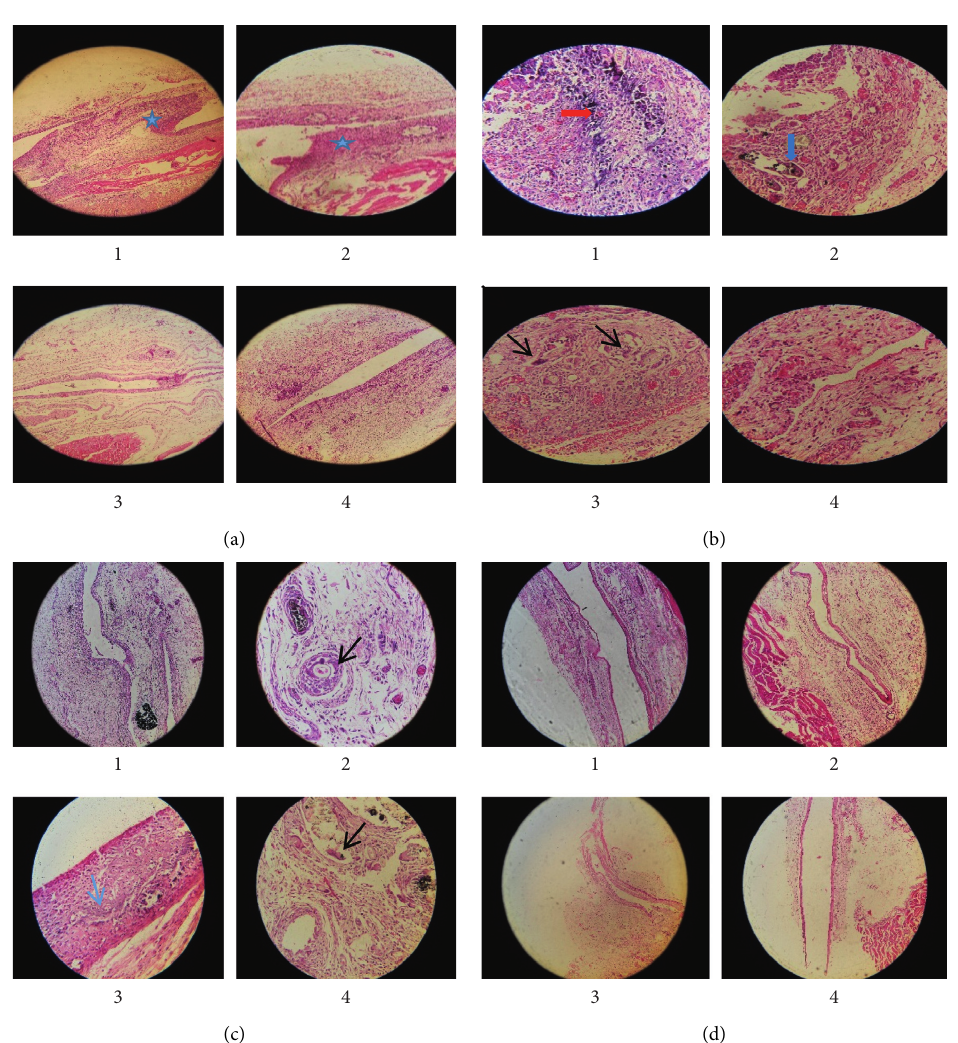
Figure 1: (a) Sample tissue of microtube implantation site on the 7 th day with hematoxylin-eosin staining; 1- MTA Bio, 2- MTA Root, 3- MTA Angelus, and 4- MTA control; magnification × 10. (b) Sample tissue of the microtube implantation site in the 7 th day with he- matoxylin-eosin staining. Black spike: giant cell, blue spike: foregin body, and red spike: calcification; 1-MTA Bio, 2- MTA Root, 3- MTA Angelus, and 4- MTA control; magnification: × 40. (c) Sample tissue of the microtube implantation site on the 15 th day with hematoxylin- eosin staining; magnification × 10, × 40; black spike: giant cell and blue spike: calcification. (d) Sample tissue of the microtube implantation site on the 60th day with hematoxylin-eosin staining; magnification ×